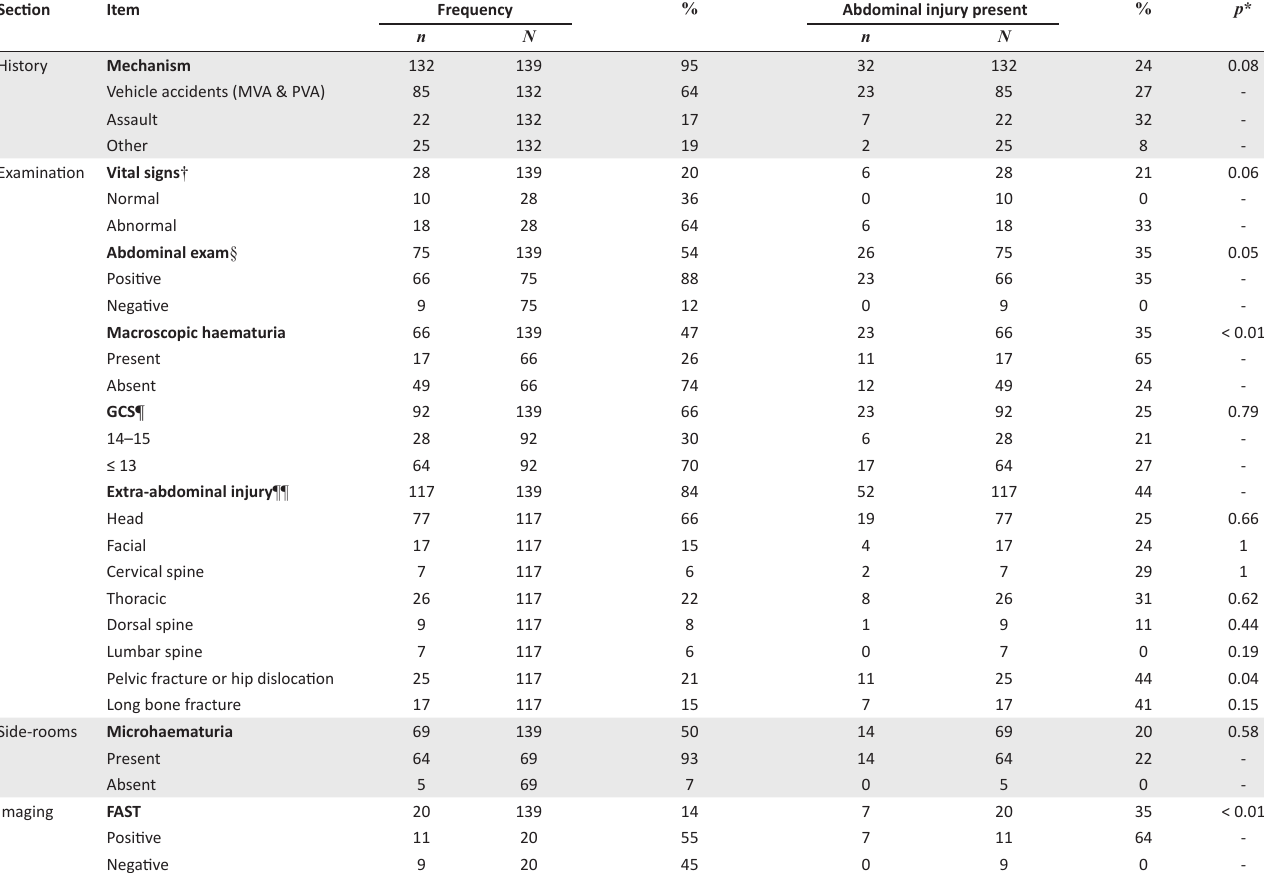
TABLE4: Association between request form detail and computed tomography evidence of abdominal injury.